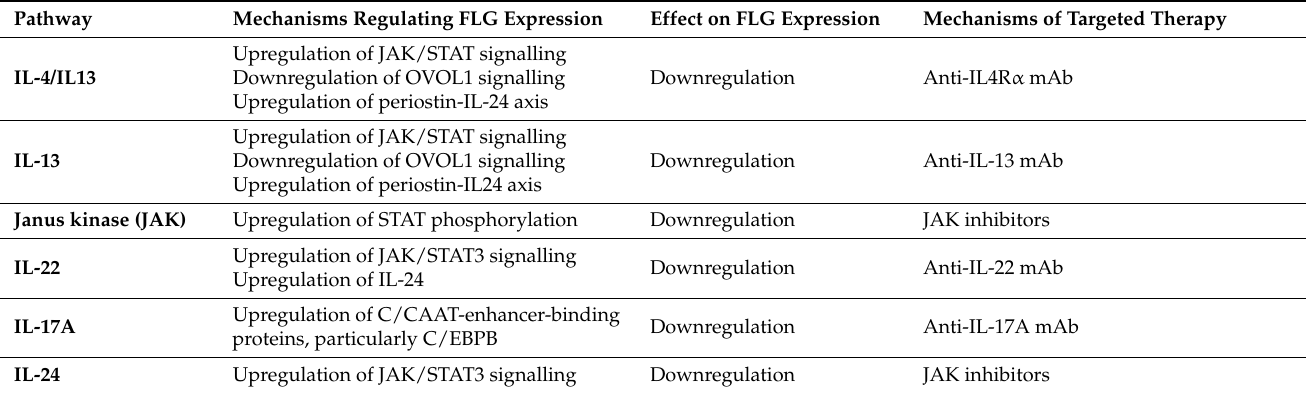
Table 2. Key immunological pathways regulating FLG